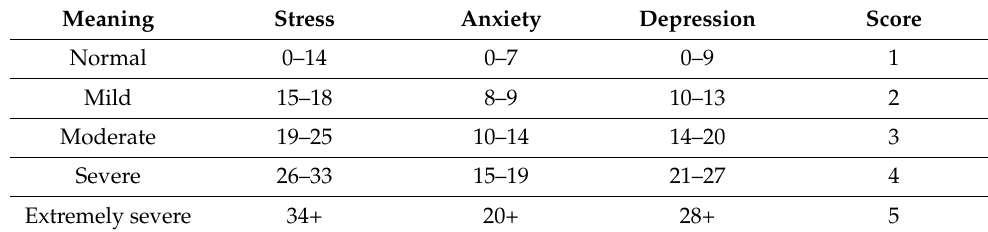
Table 1. Score and cutoff values on the DASS-21. Meaning Stress